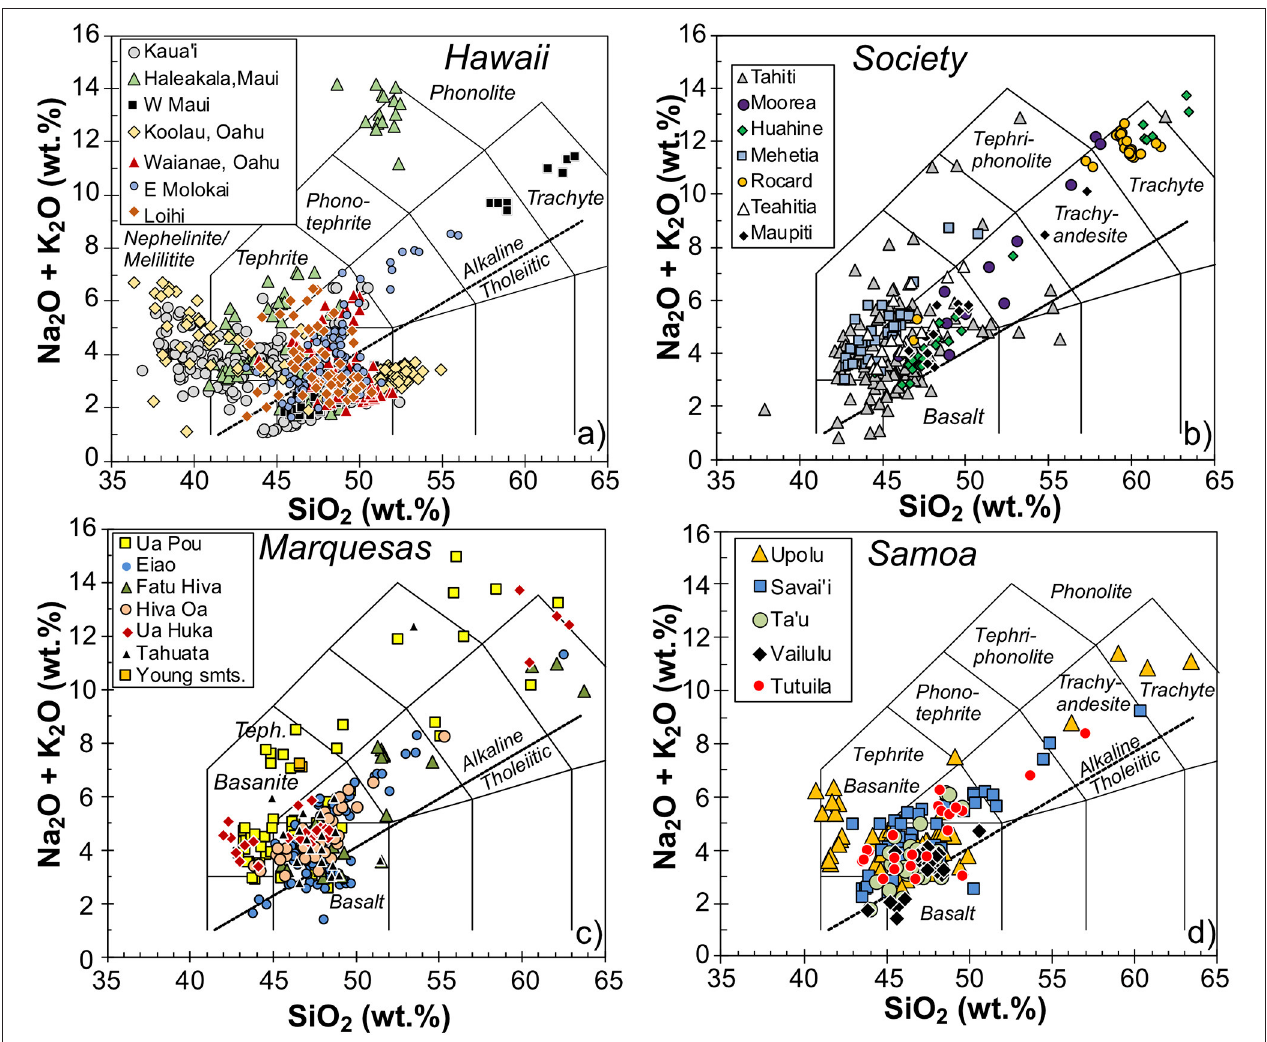
FIGURE 2 | The total alkalies-silica (TAS) diagram (Le Bas et al., 1986) for lavas from different volcanoes of the (a) Hawaiian, (b) Society, (c) Marquesas, and (d) Samoa hotspots. The dashed line shows the distinction between alkaline and tholeiitic lavas after Macdonald and Katsura (1964). Data sources can be found in the Supplementary Material